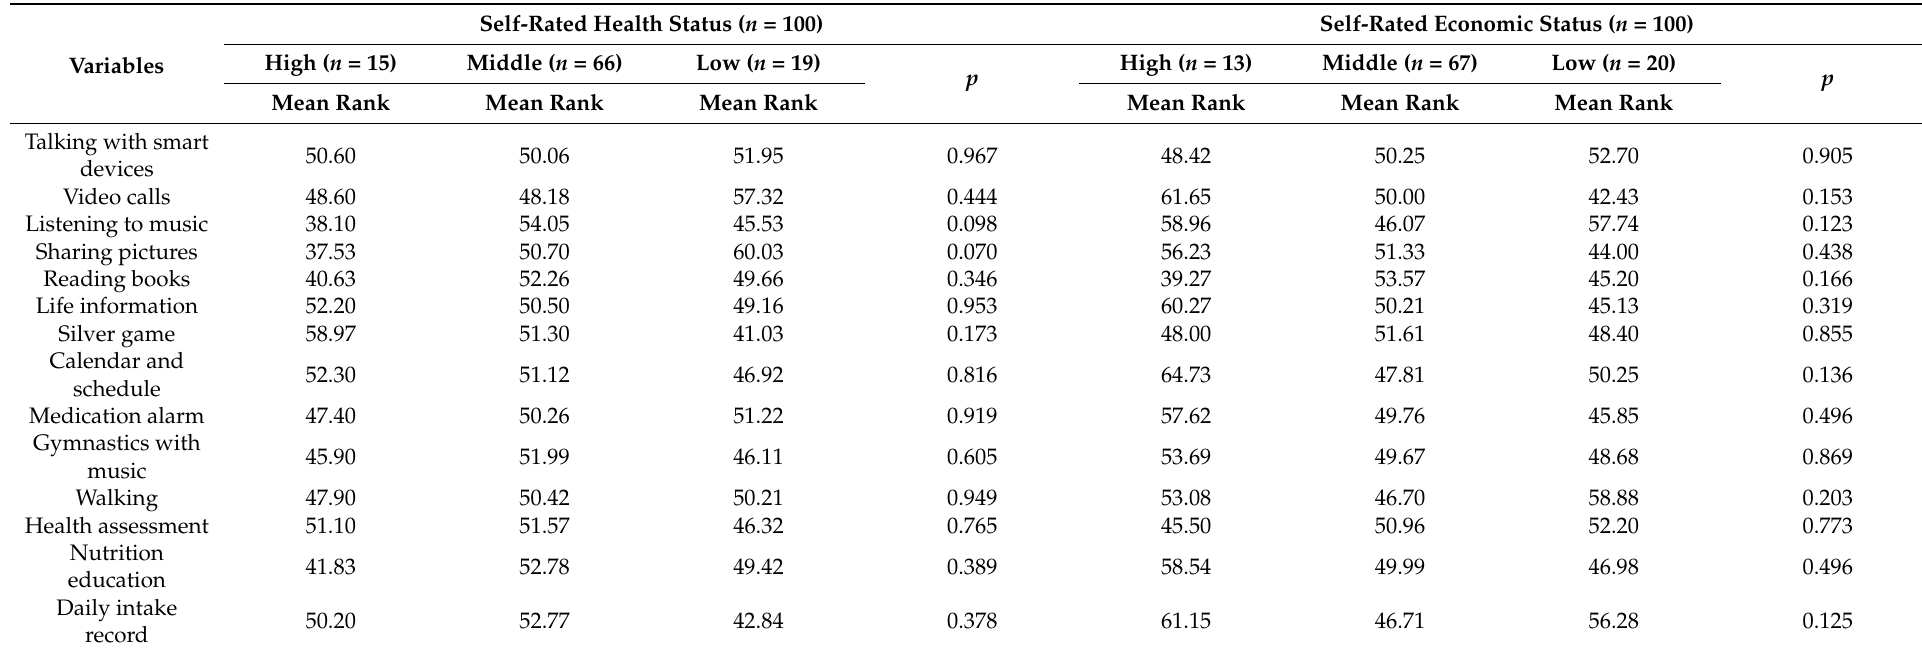
Table 6. Differences in preference related to non-face-to-face services according to self-rated health and economic status (N =